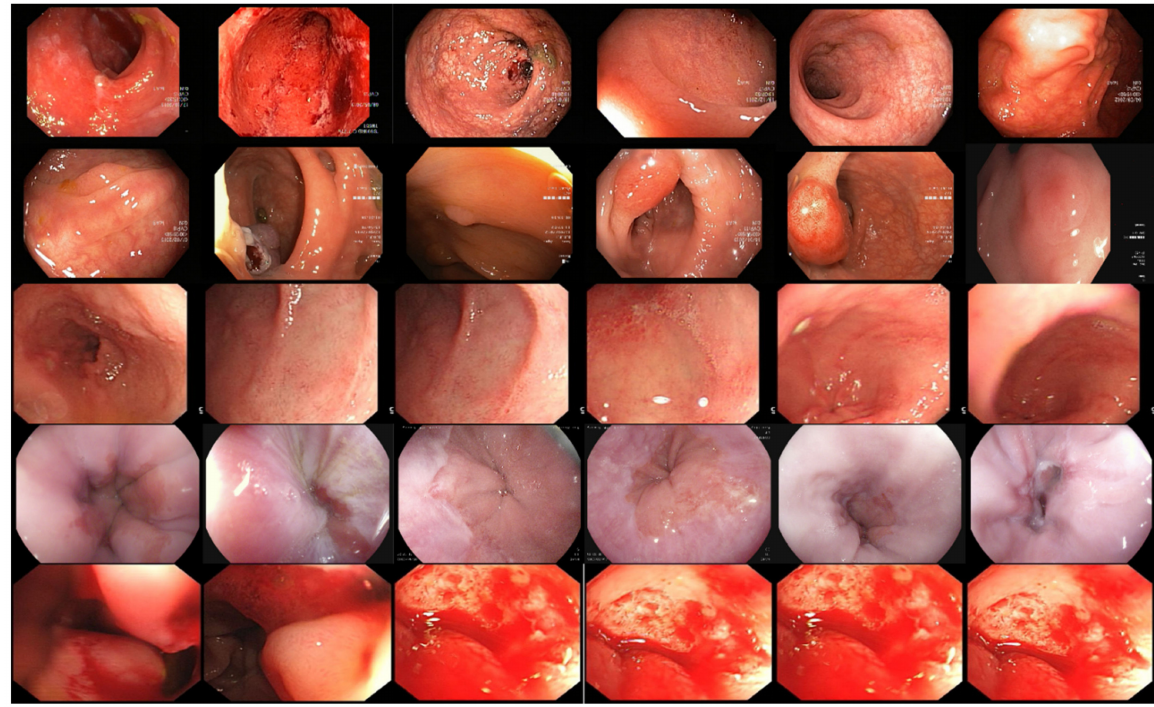
Figure 6. Sample images from stomach disease classification